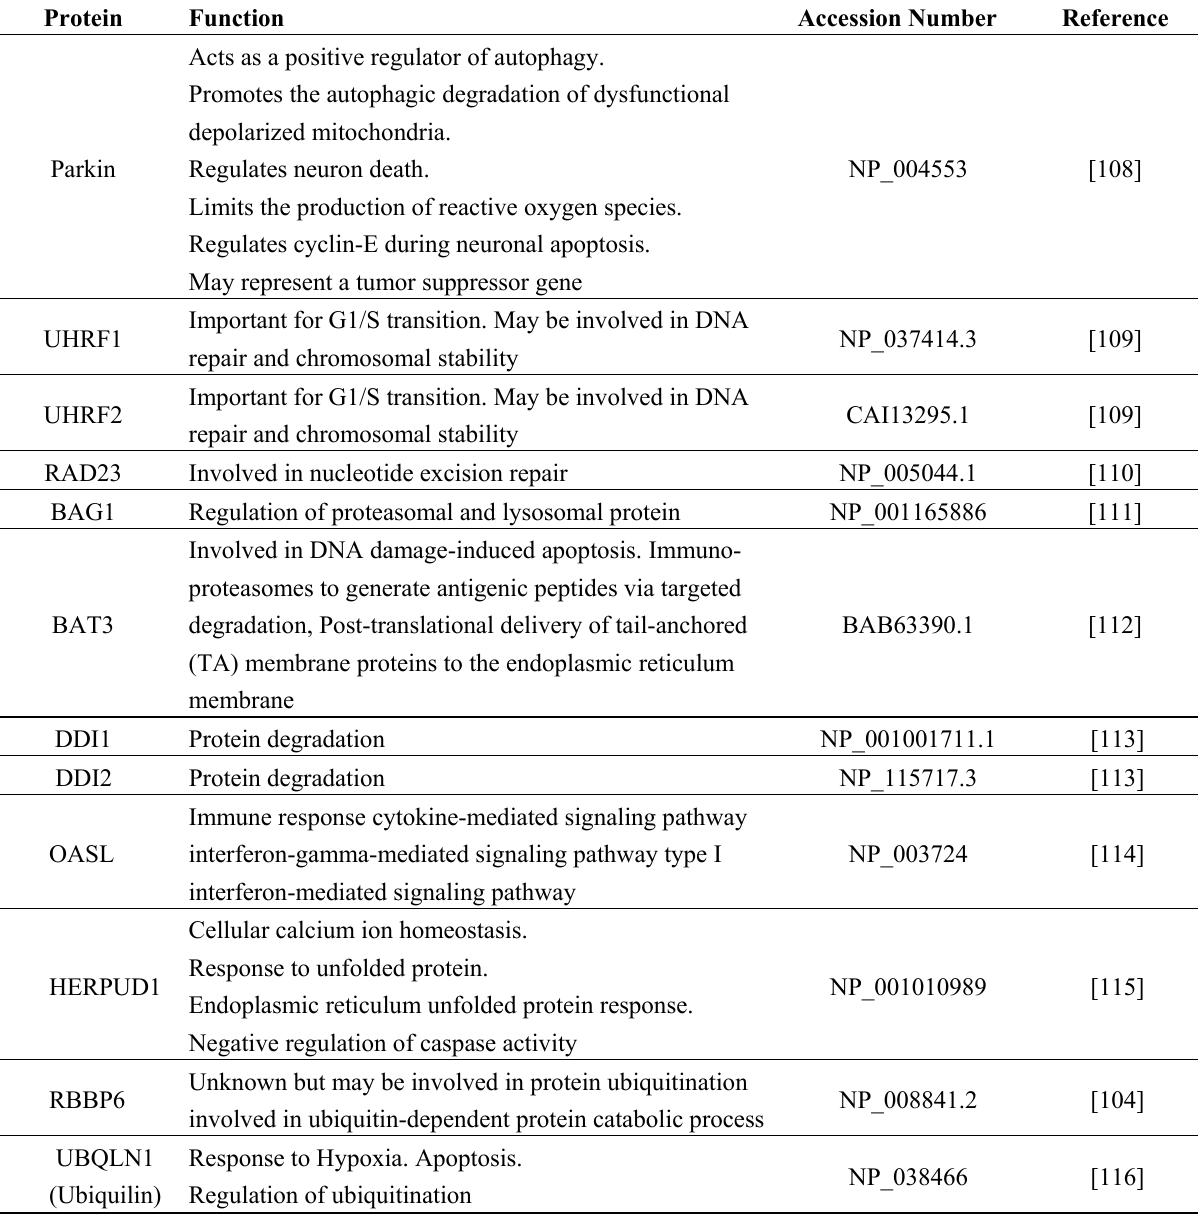
Table 2. Proteins with ubiquitin-like